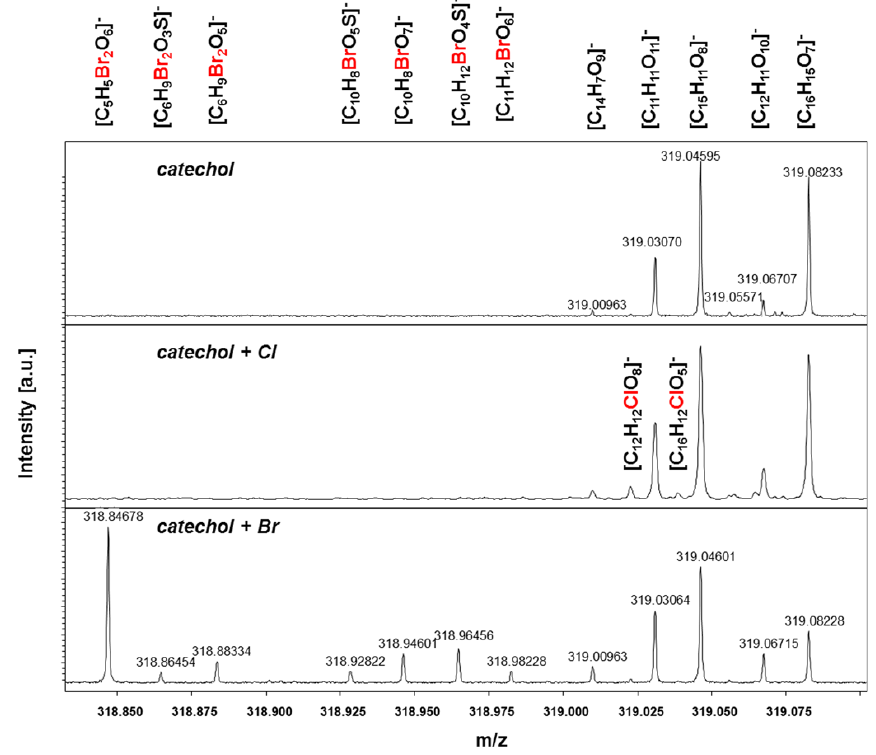
Fig. 6. ICR-FT/MS nominal mass 319 with detailed halogenations with Cl and Br exemplified with catechol.